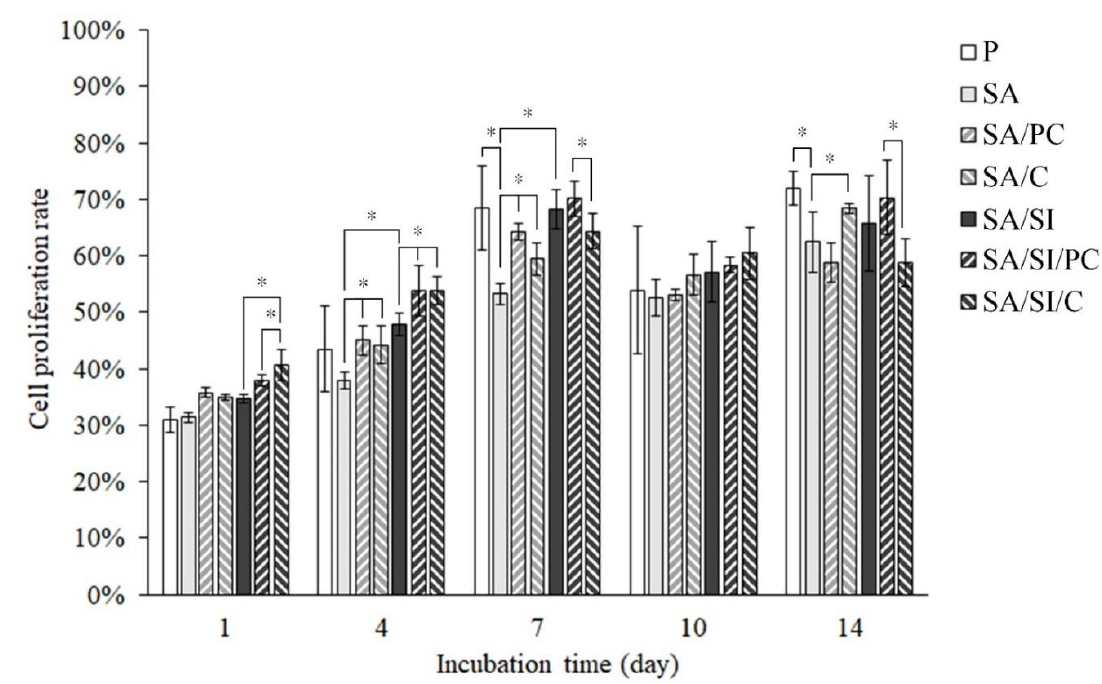
Figure 9. Cell metabolic proliferation assay analysis (AlamarBlue ® kit) of the D1 cell proliferation test on surface-modified PEEK for 1, 4, 7, 10, and 14 days ( n = 6). Character symbols * indicate that each testing group after one-way ANOVA is significantly different ( p < 0.05).